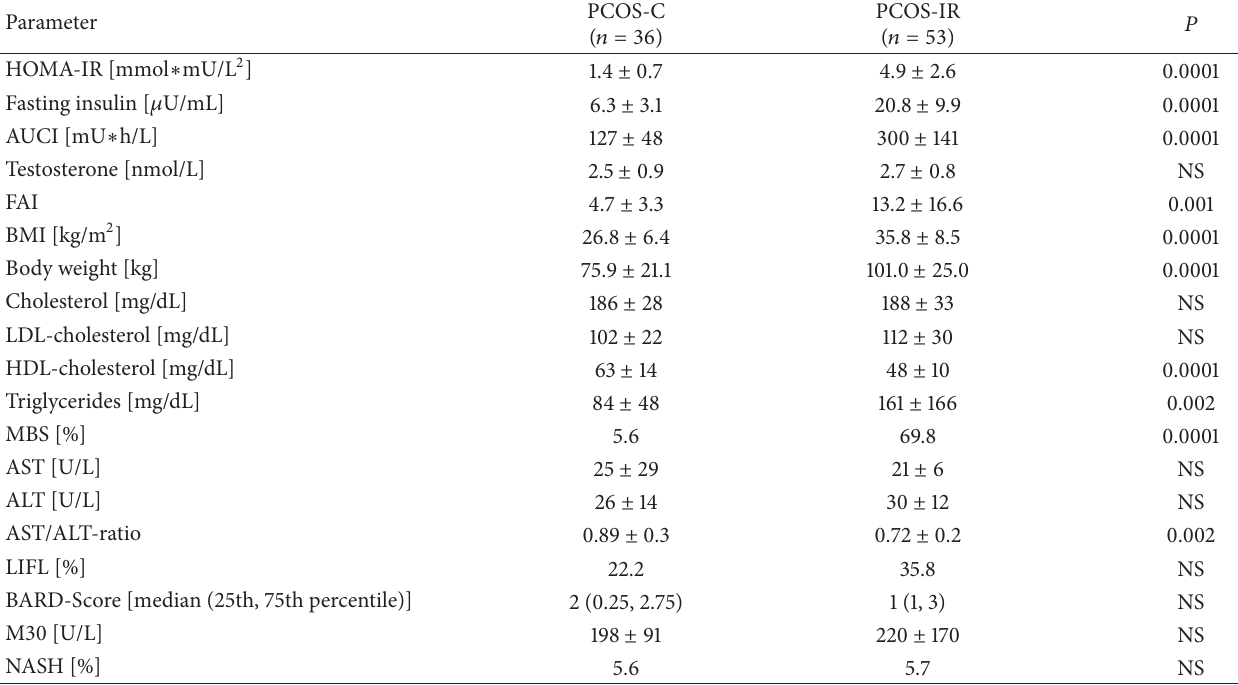
Table1:BaselinecharacteristicsofpatientswithPCOS.ComparisonofbaselinecharacteristicsofPCOSpatientswith(PCOS-IR)andwithout IR (PCOS-C). Data were analyzed by 𝑡 -tests, Mann-Whitney 𝑈 test (for BARD-Scores), or Chi 2 -tests (for dichotomous variables). Values are given as mean ± standard deviation, unless otherwise